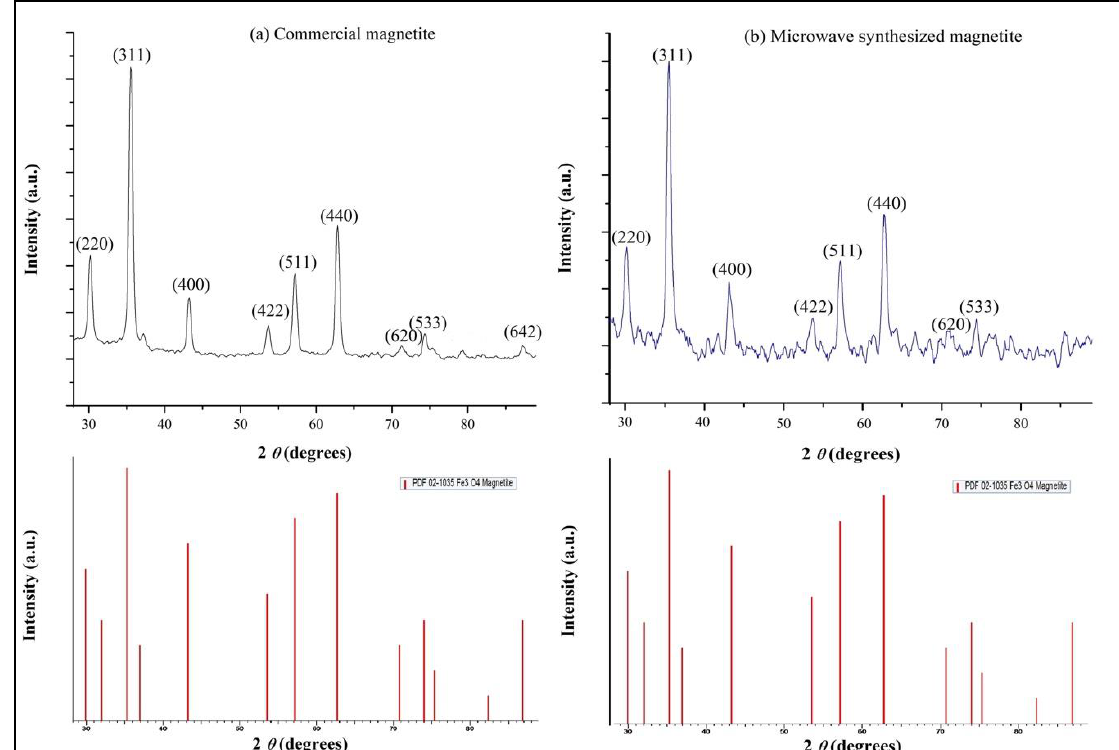
Figure 1. X-ray diffraction spectra of ( a ) commercially available magnetite particles and ( b ) the microwave-synthesized magnetite particles.